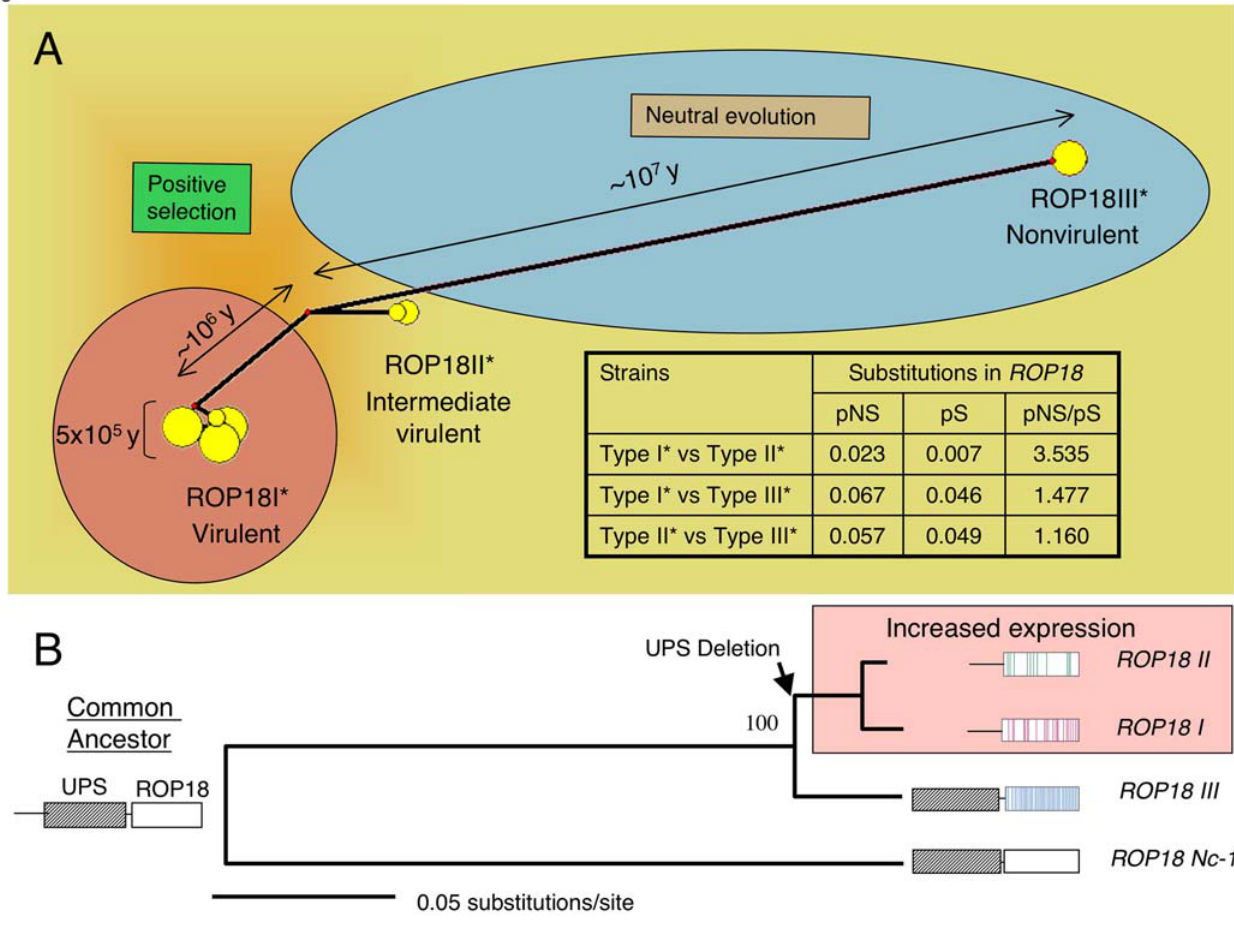
Figure 7. Evolutionary history of ROP18 : changes in expression levels of ROP18 correlate with acute virulence. A) Network analysis of ROP18 reveals two different periods of evolution. A long period of nearly neutral evolution differentiated type III* from the ancestor of types I* and II*. More recently, the types I* and II* diverged under a period of strong selection. Acute virulence is associated with the successful expansion of the type I* alleles. Table includes proportion of nonsynonymous (pNS)/synonymous (pS) substitutions for ROP18 (see also Table S3 for additional ratios). Age estimates are based on synonymous changes in ROP18 from the data in Table S5. B) Out-group rooting using the ROP18 homologue in Neospora caninum confirms that the type III* lineage has undergone a longer period of independent evolution than have types I* and II*, which shared a more recent common ancestor. Neighbor joining analysis based on the coding regions of ROP18 . Bootstrap values based on 1000 replicates. Color bars in the ROP18 models for each strain type denote the positions of allele-specific